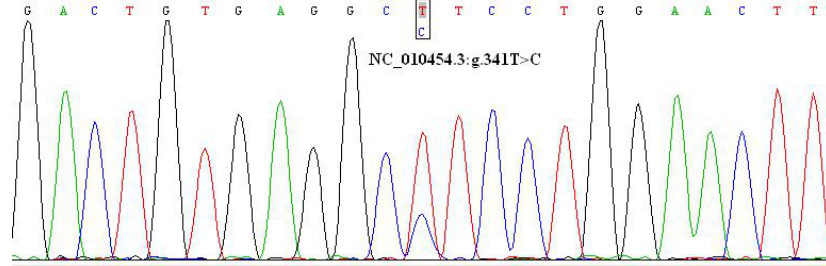
Figure 1. Sequence chromas of the anonymous mutation (NC_010454.3:g.341T > C) in the pig TMEM95 gene.